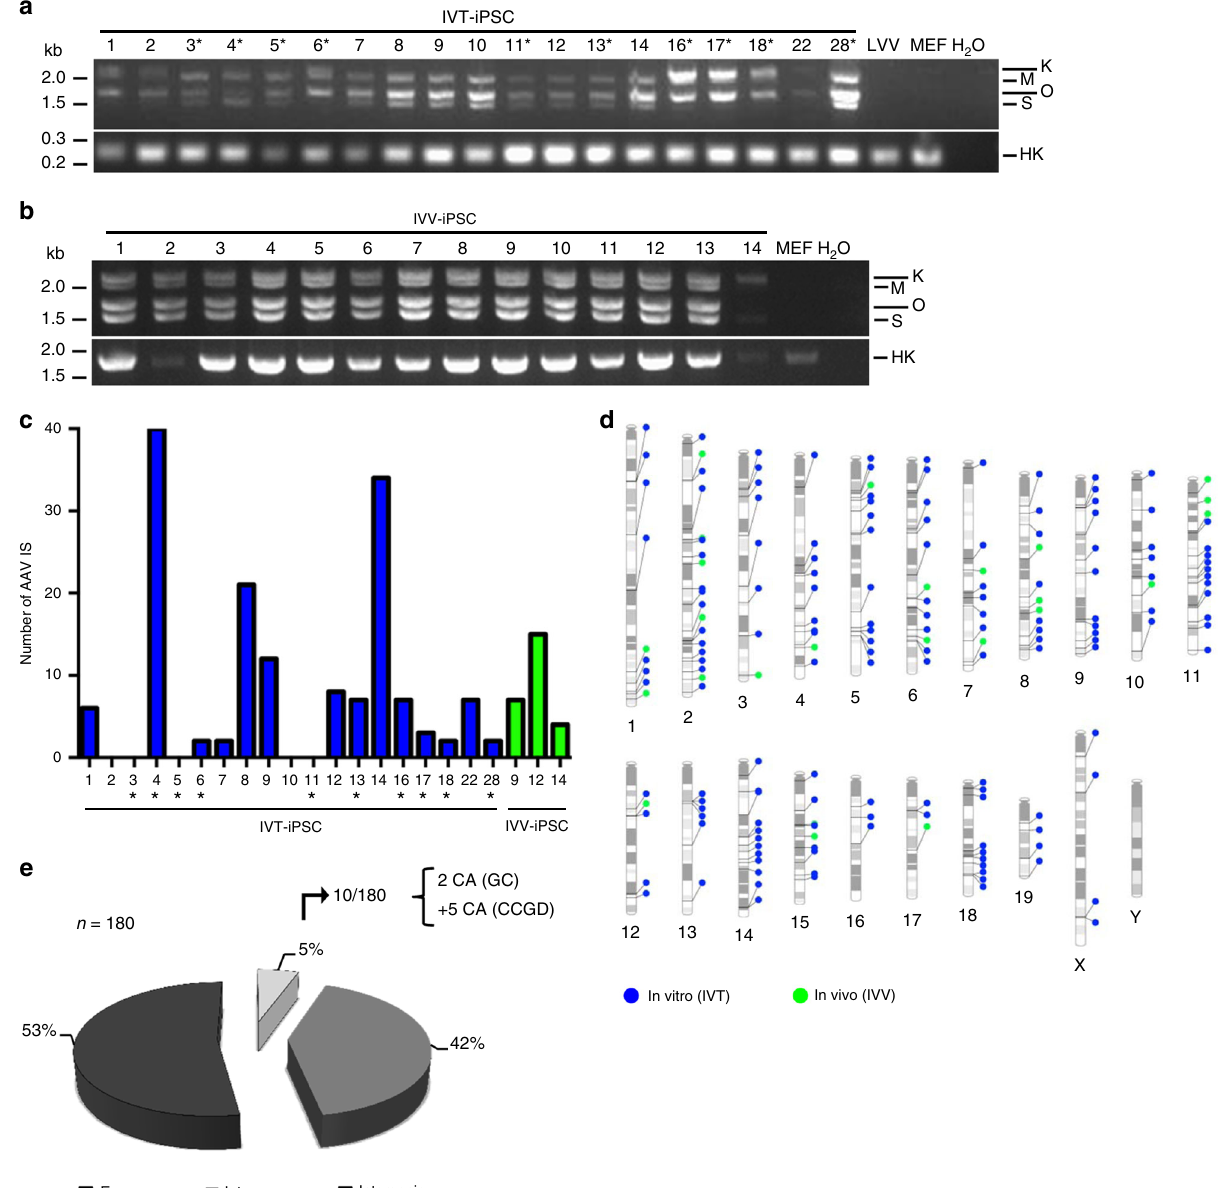
Fig. 4 Analysis of AAV vector traces and integration sites in scAAV/OKSM-derived cellular clones. a PCR analysis of 19 clones generated in vitro and analyzed at an early passage (between passage 0 and 6). Top gel: PCR with primers amplifying the whole cassette, from SFFV promoter to polyadenylation signal. Three or four distinct bands are detected, which correspond to the four AAV reprogramming vectors used. Bottom gel: PCR to detect the Hprt housekeeper (HK) gene. LVV, iPSC cells generated with a lentiviral vector encoding human codon-optimized OKSM; MEF, untreated MEF; H 2 O, control PCR using water instead of DNA template. Sizes of a DNA marker are shown in kilobases (kb) on the left. The asterisks highlight IVT-iPSC clones which may not have been fully reprogrammed (Supplementary Data 1). b PCR analysis of 14 AAV-iPSC clones generated in vivo using a MOI of 2 × 10 11 and analyzed at an early passage (between passage 2 and 4). See panel a for details as well as Supplementary Data 1 for information on all clones. c Graph showing the number of AAV insertion sites (IS) identi fi ed by nrLAM-PCR or TES in the cellular clones shown in a (blue bars, generated in vitro) and b (green bars, generated in vivo). d PhenoGram plot (generated with the tool http://visualization.ritchielab.psu.edu/phenograms/plot) depicting the distribution of AAV IS across all mouse chromosomes, segregated into cellular clones generated in vitro (blue) or in vivo (green) (same color scheme as in c ). e Pie chart illustrating the proportions of AAV vector integrations (total n = 180) in exons, introns or intergenic regions. Of the 10 hits in exons, two affected cancer-associated (CA) genes based on the Genecards (GC) database, or seven based on the Candidate Cancer Gene Database (CCGD)